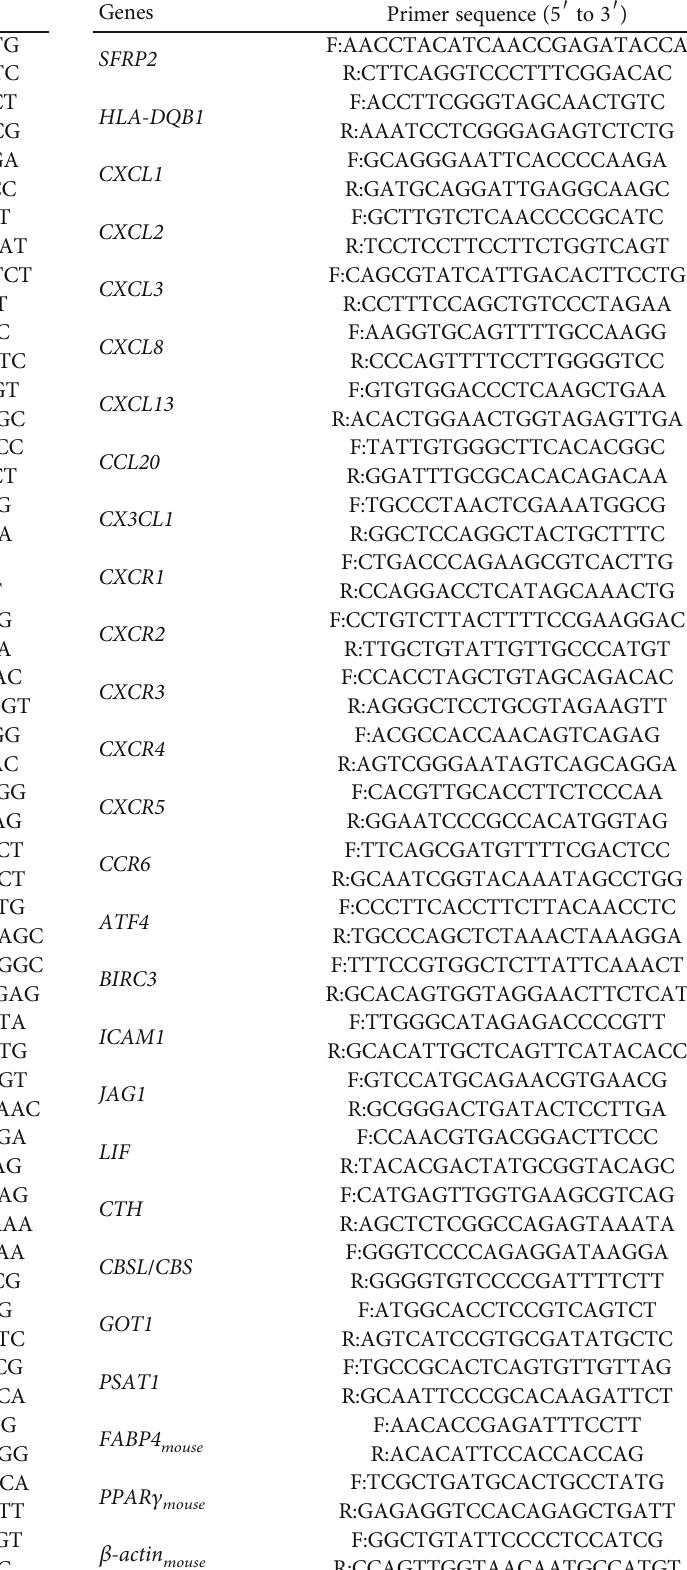
Table 1: Primers for RT-qPCR. Table 1: